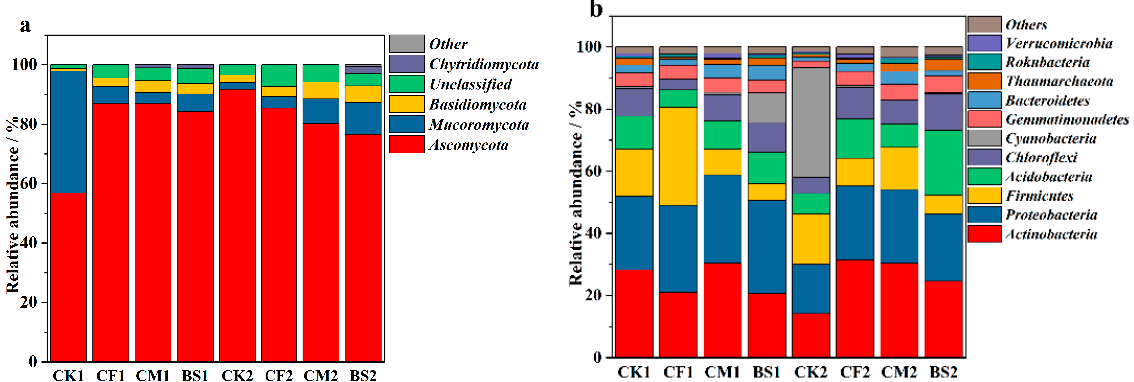
Figure 2. The soil microbial community composition under different fertilization treatments in phy- lum levels of fungi ( a ) and bacteria ( b ). 1: 0–20 cm depth layer; 2: 20–40 cm depth layer. CK: Control Group, CF: Chemical Fertilizer, CM: Composted Manure, BS: Biogas